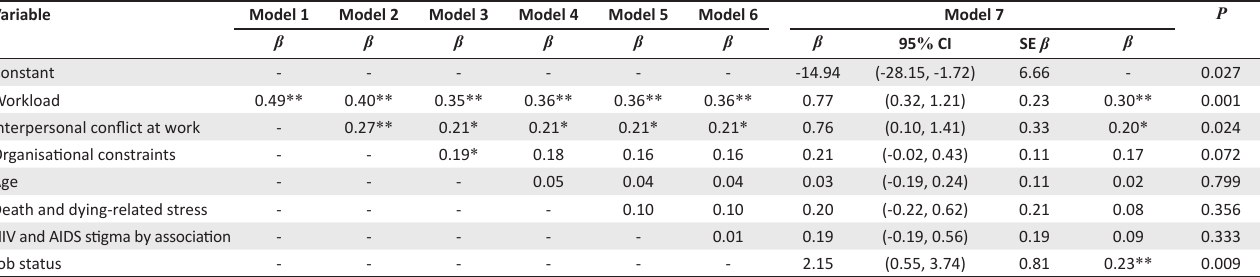
TABLE 4: Predictors of emotional